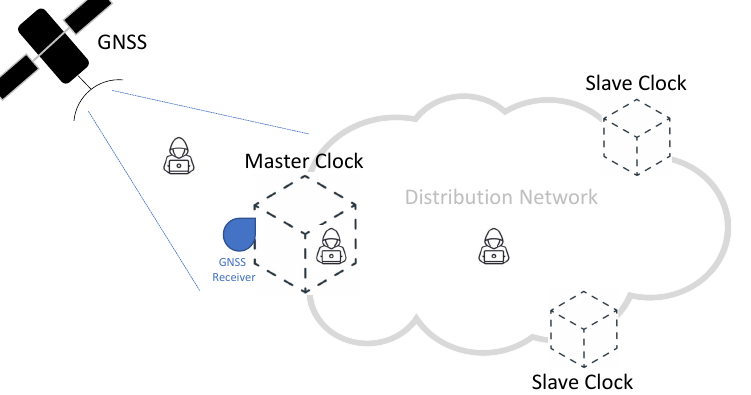
Figure 1. Simplified scheme of a Global Navigation Satellite System (GNSS)-based synchronization distribution